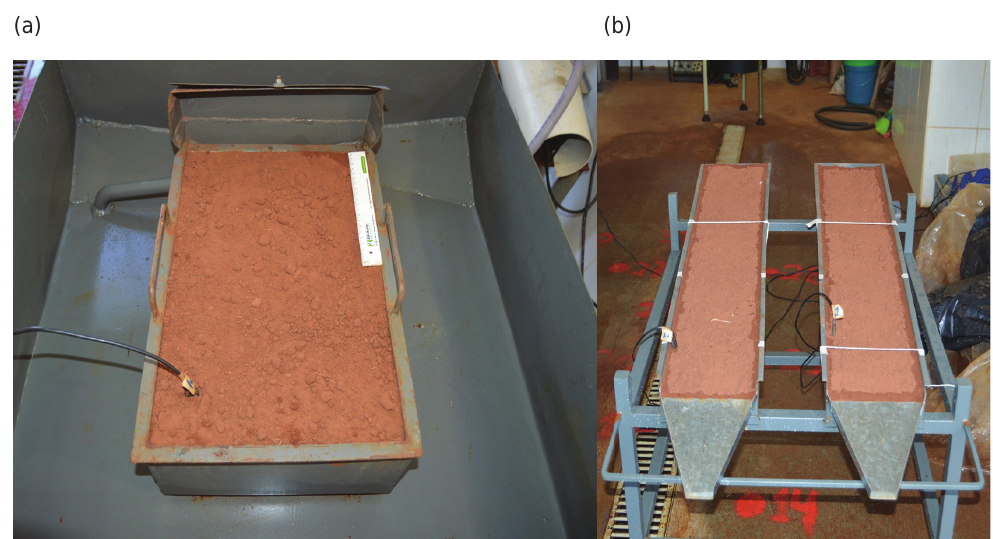
Figure 2. Splash pan with a shield to collect the splashed soil particles (a) and small flume to determine interrill soil erodibility